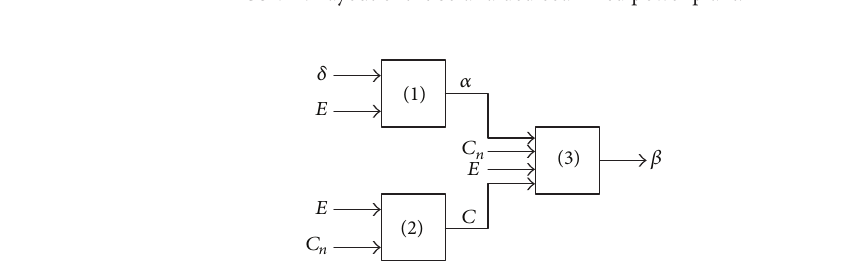
Figure 1: Layout of the solar aided coal-fired power plant.